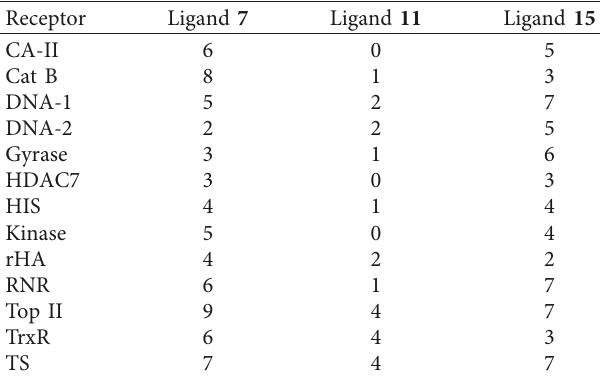
Figure 4: The binding site interactions of the three ligands 7 (grey), 11 (green), and 15 (yellow) with each of the receptors. Table 3: The number of hydrogen bonds (HBs) in the interactions of the ligands 7 , 11 , and 15 with the